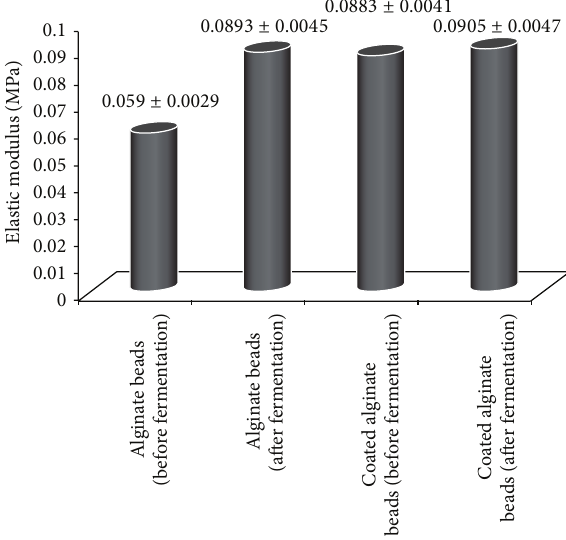
Figure 6: Elastic modulus of alginate beads with encapsulated probiotics before and after the fermentation process for 30% sample deformation (means values ± SD, 𝑛 = 30 ), alginate concentration 1.7% (w/v). Figure 7: Influence of the chitosan coating on mechanical strength